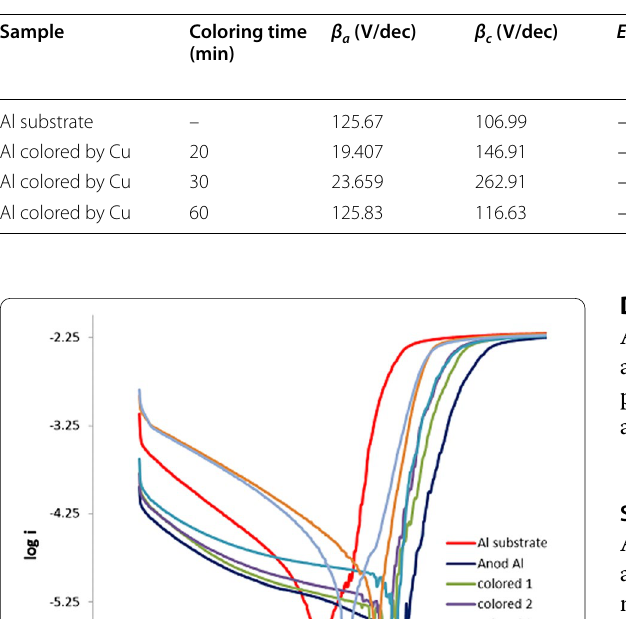
Table 4 Tafel parameters of aluminum and electrolytically colored aluminum samples by Cu at different anodization times of 20, 30 and 60 min